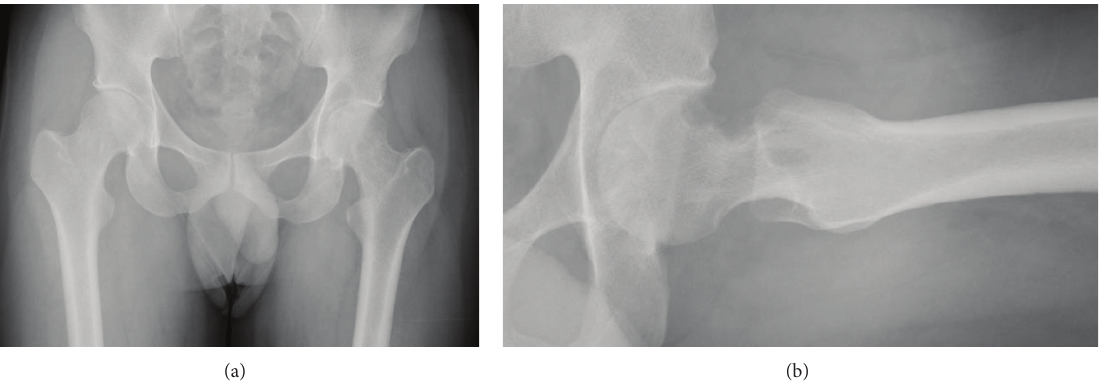
Figure 1: (a, b) Joint narrowing and multiple bone erosions of the hip joint are seen on this roentgenogram.